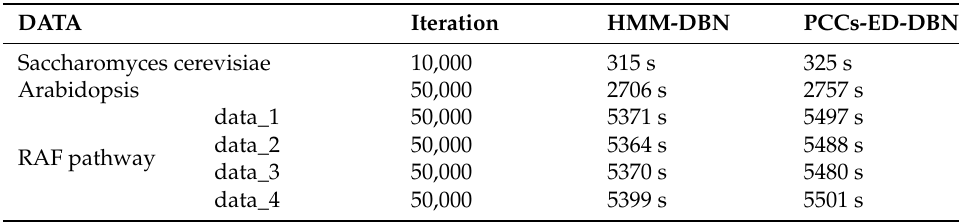
Table 4. time overhead comparison between HMM-DBN and PCCs-ED-DBN.